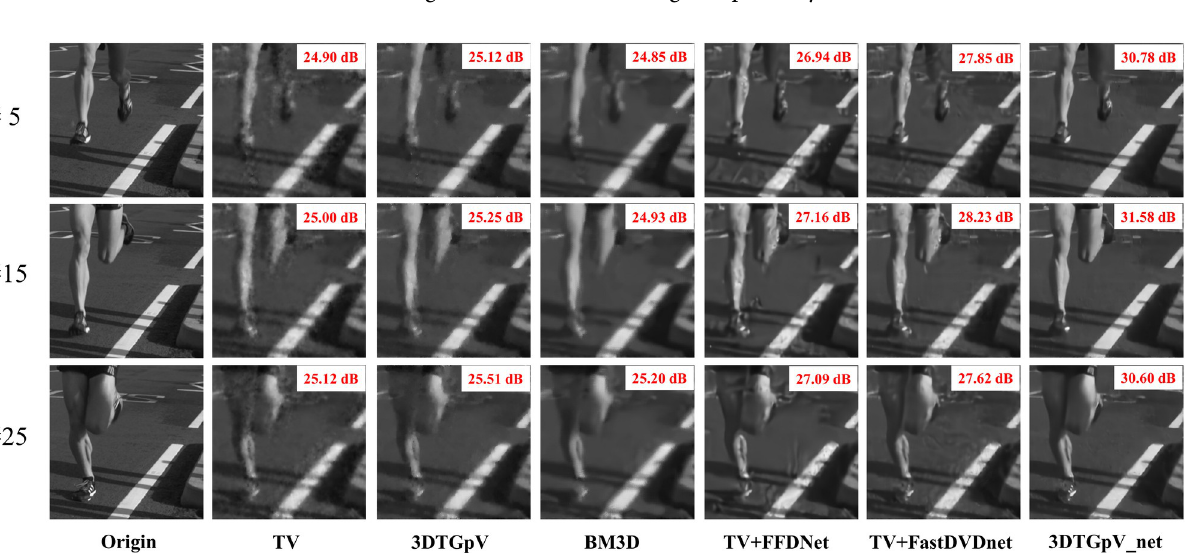
PLOS ONE | https://doi.org/10.1371/journal.pone.0271441 August 12,